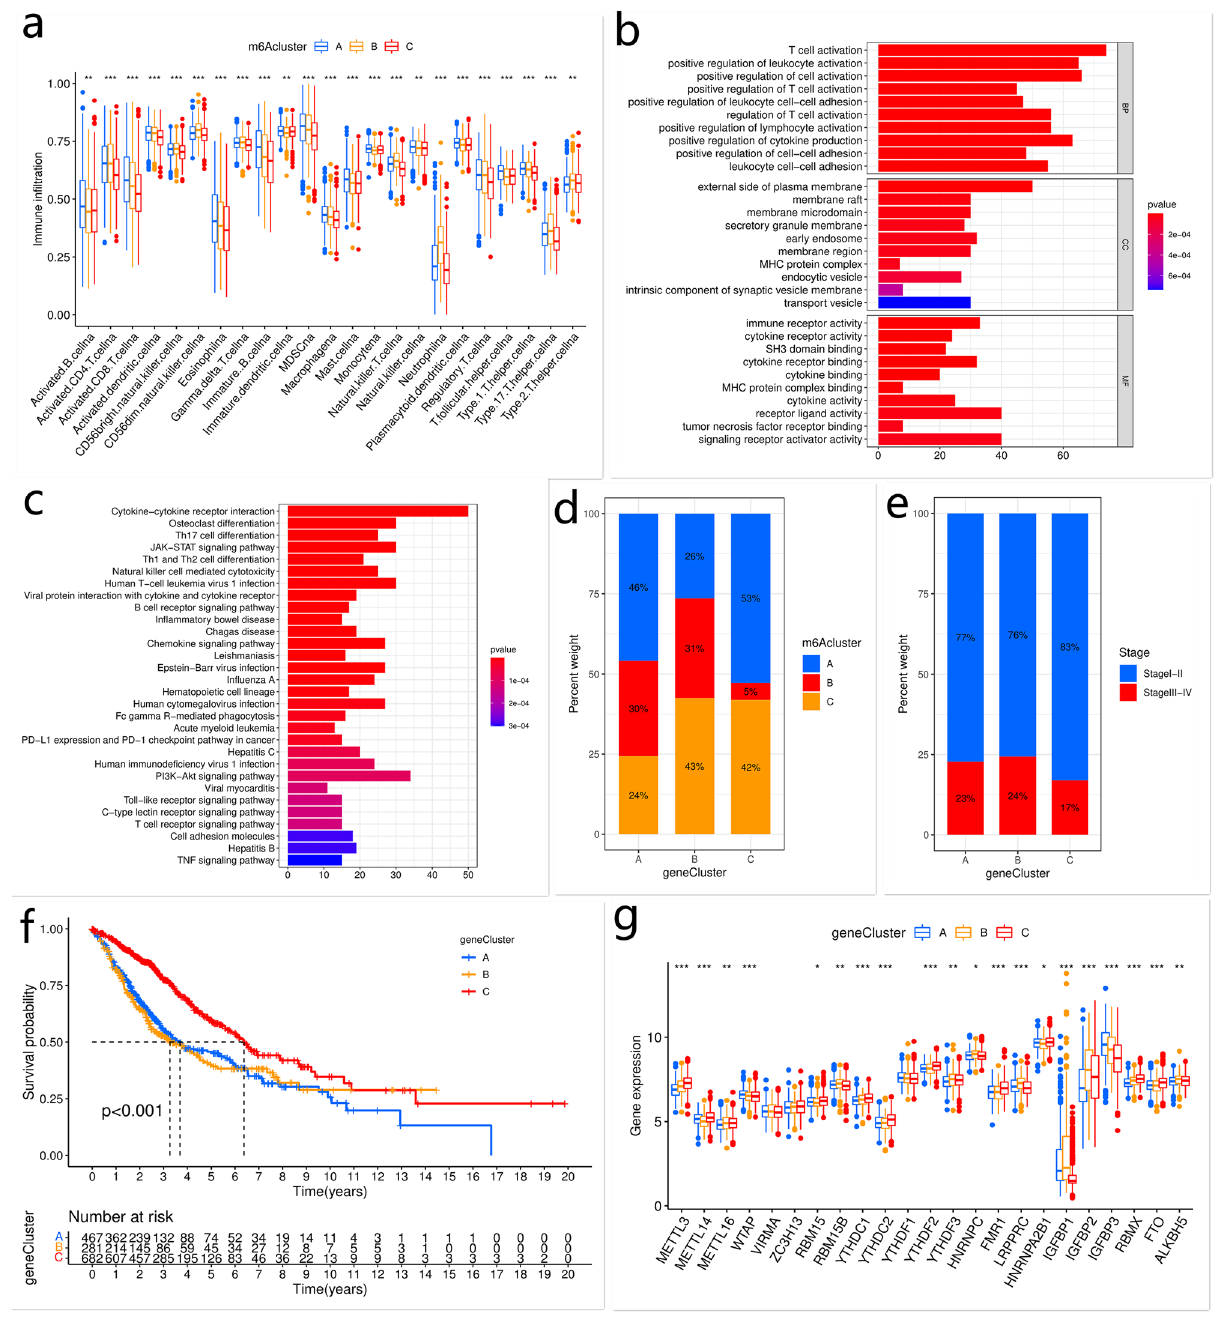
related DEGs ( b , c ). The percentage of patients with m 6 Acluster-A/-B/-C in each m 6 A geneCluster ( d ). The percentage of patients with stage I, II/III, and IV LUAD in each m 6 A geneCluster ( e ). The Kaplan–Meier curves of the OS of LUAD patients in different m 6 A geneClusters ( f ). The expression of m 6 A regulators in distinct m 6 A geneclusters ( g ). This figure is created using the R (version 4.0.3) (https:// www.r- proje ct.